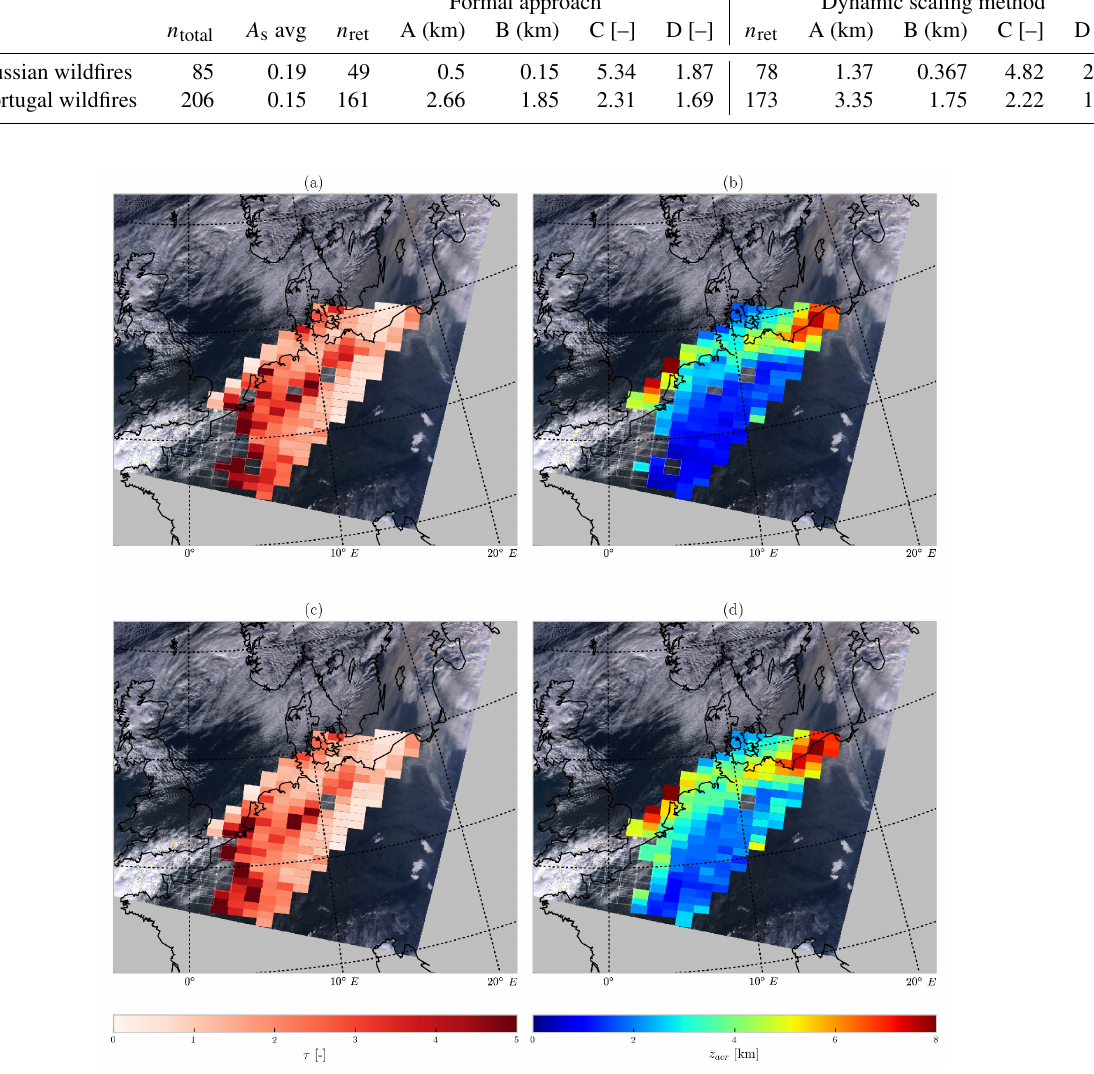
Figure 7. Results from processing 206 GOME-2B pixels over western Europe using the formal approach and the dynamic scaling method. Empty GOME-2B pixels with a white border represent non-convergences. (a) Fitted τ at 760nm from the formal approach. (b) Retrieved z aer from the formal approach. (c) Fitted τ at 760nm from the dynamic scaling method. (d) Retrieved z aer from the dynamic scaling method. The background image is a subset of the MODIS Terra image in Fig.